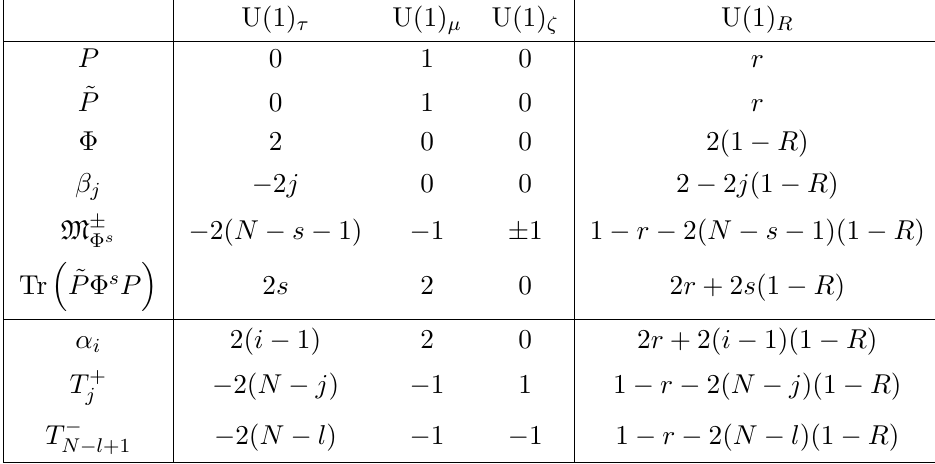
Table 1 . Charges under the global symmetries and R-charges of all the chiral (cid:12)elds and all the chiral ring generators of the dual